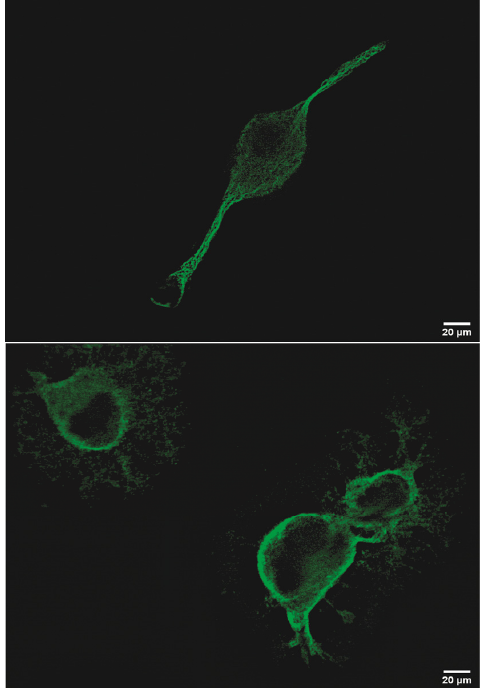
Figure 5. Upper panel, immunofluorescence of N2a cells incubated for 24 h with oligomers treated with compound 2 . Lower panel, immunofluorescence of N2a cells incubated with tau aggregates alone: bars 20 µm.